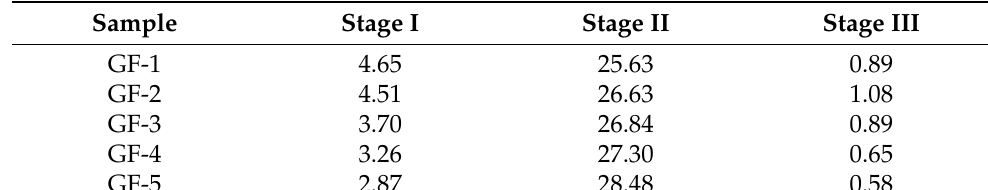
Table 6. Weight loss of HBSC raw materials in TG curves (%).